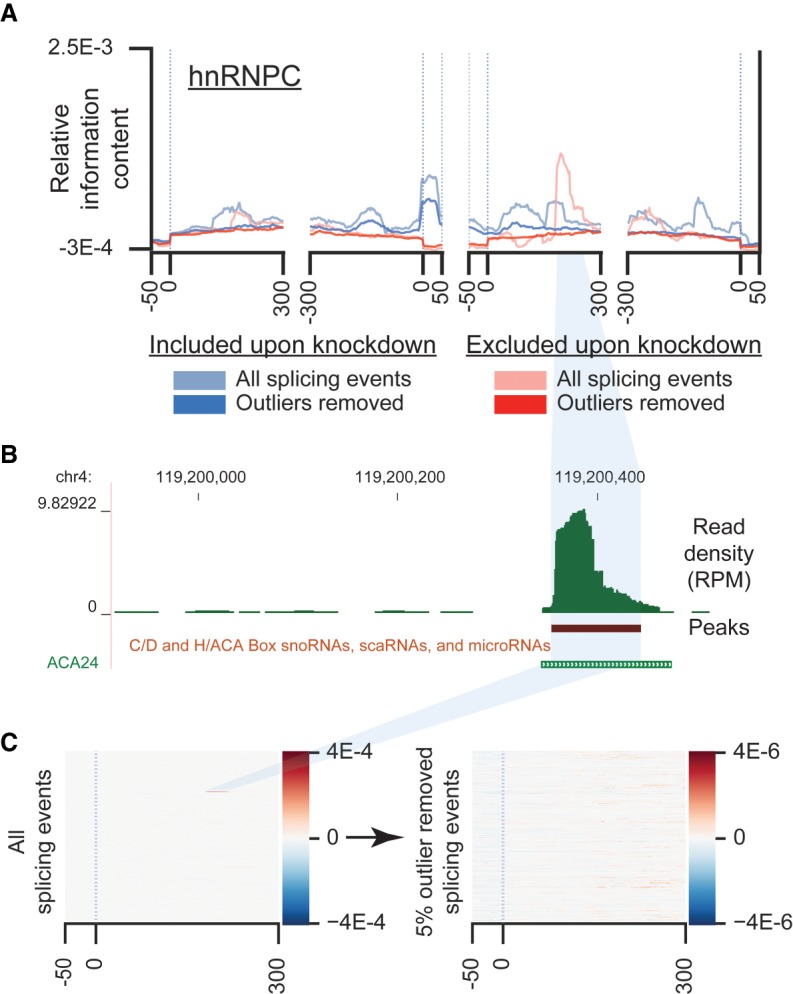
Removing outliers removes local artifacts that may confound global signal. (A) Figure shows splicing map of HNRNPC in HepG2 either including all events or excluding outliers (defined as the top and bottom 2.5% of values at each position). (B) Genome browser track shows an example outlier, HNRNPC HepG2 eCLIP read density at ACA24. (C) Heatmaps indicate normalized density tracks for all HNRNPC knockdown-excluded events (left) before and (right) after removal of outliers.